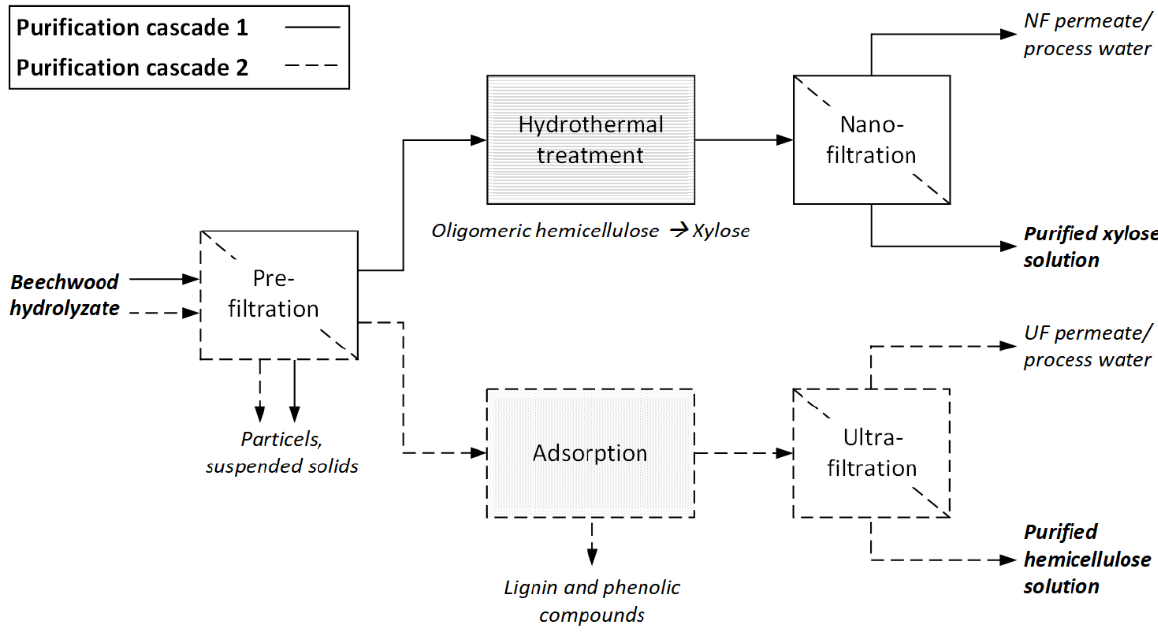
Figure 1. Purification cascades 1 (solid line) and 2 (dotted line) for the separation and valorization of hemicellulose from organosolv beechwood hydrolyzate.